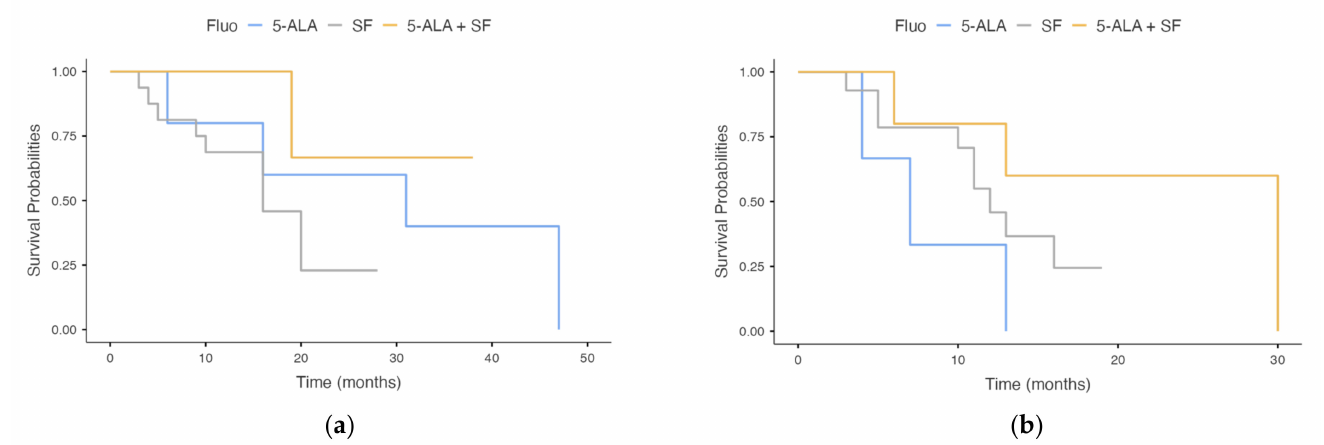
Figure 3. Kaplan–Meier survival analysis of OS stratified for different fluorophores and for MGMT promoter status. ( a ) MGMT promoter methylated; ( b ) MGMT promoter not methylated. The contemporary use of both fluorophores seems to provide some benefit, although statistically insignificant ( p =